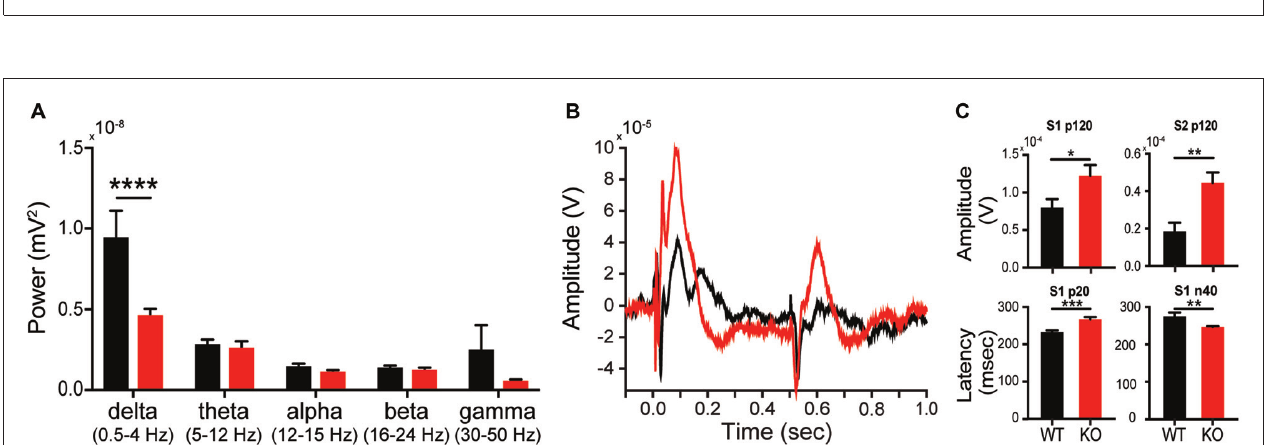
FIGURE 7 | Altered long term depression in the striatum of the Shank2 KO rat. In the striatum (brain slice depicts location of stimulating and recording electrode), KO rats show enhanced LTD (A) with increased depression relative to baseline 40 min after low frequency presynaptic stimulation (indicated by black bar) (B) . In all panels WT animals are in black and KO animals are in red. Bars indicate SEM. ∗ p < 0.05.